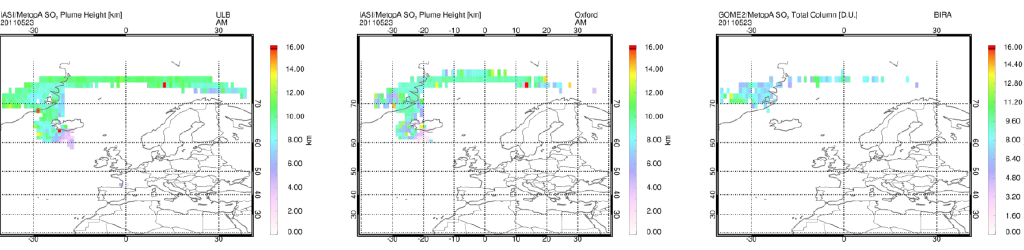
Figure 2: Estimated total SO 2 plume height over Europe on May 23rd 2011 as deduced by the ULB/IASI algorithm [left], the Oxford/IASI algorithm [middle] and the BIRA­IASB/GOME­2 algorithm